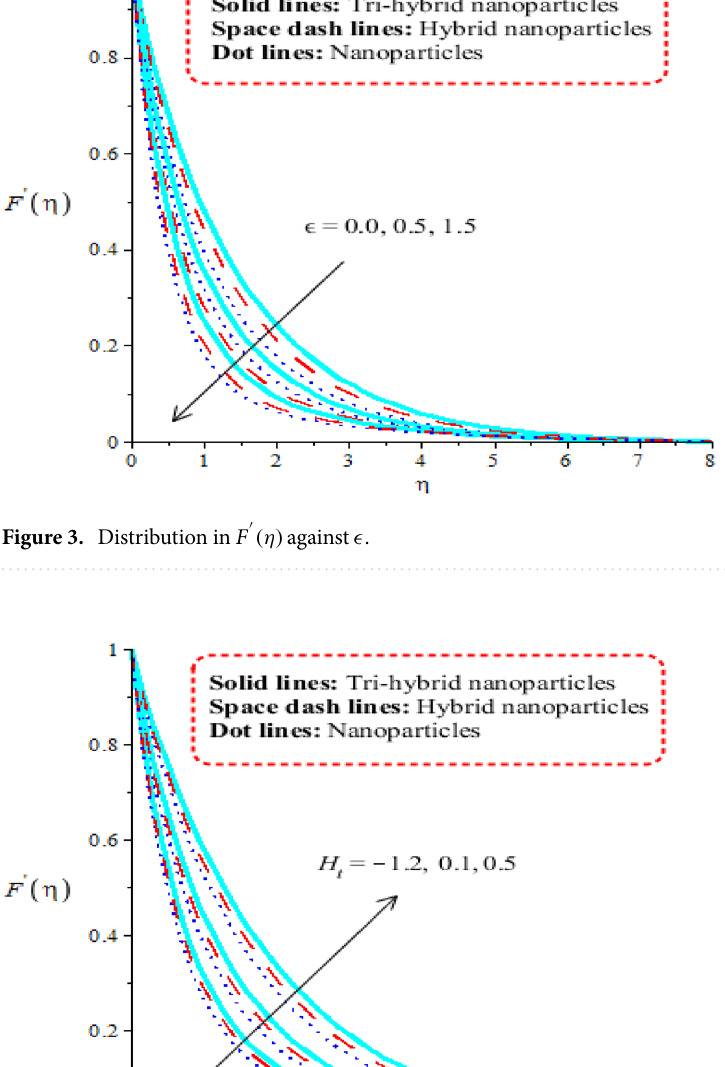
profile. Buoyancy force is made reason for development of (cid:31) in current model. Production of thermal energy is